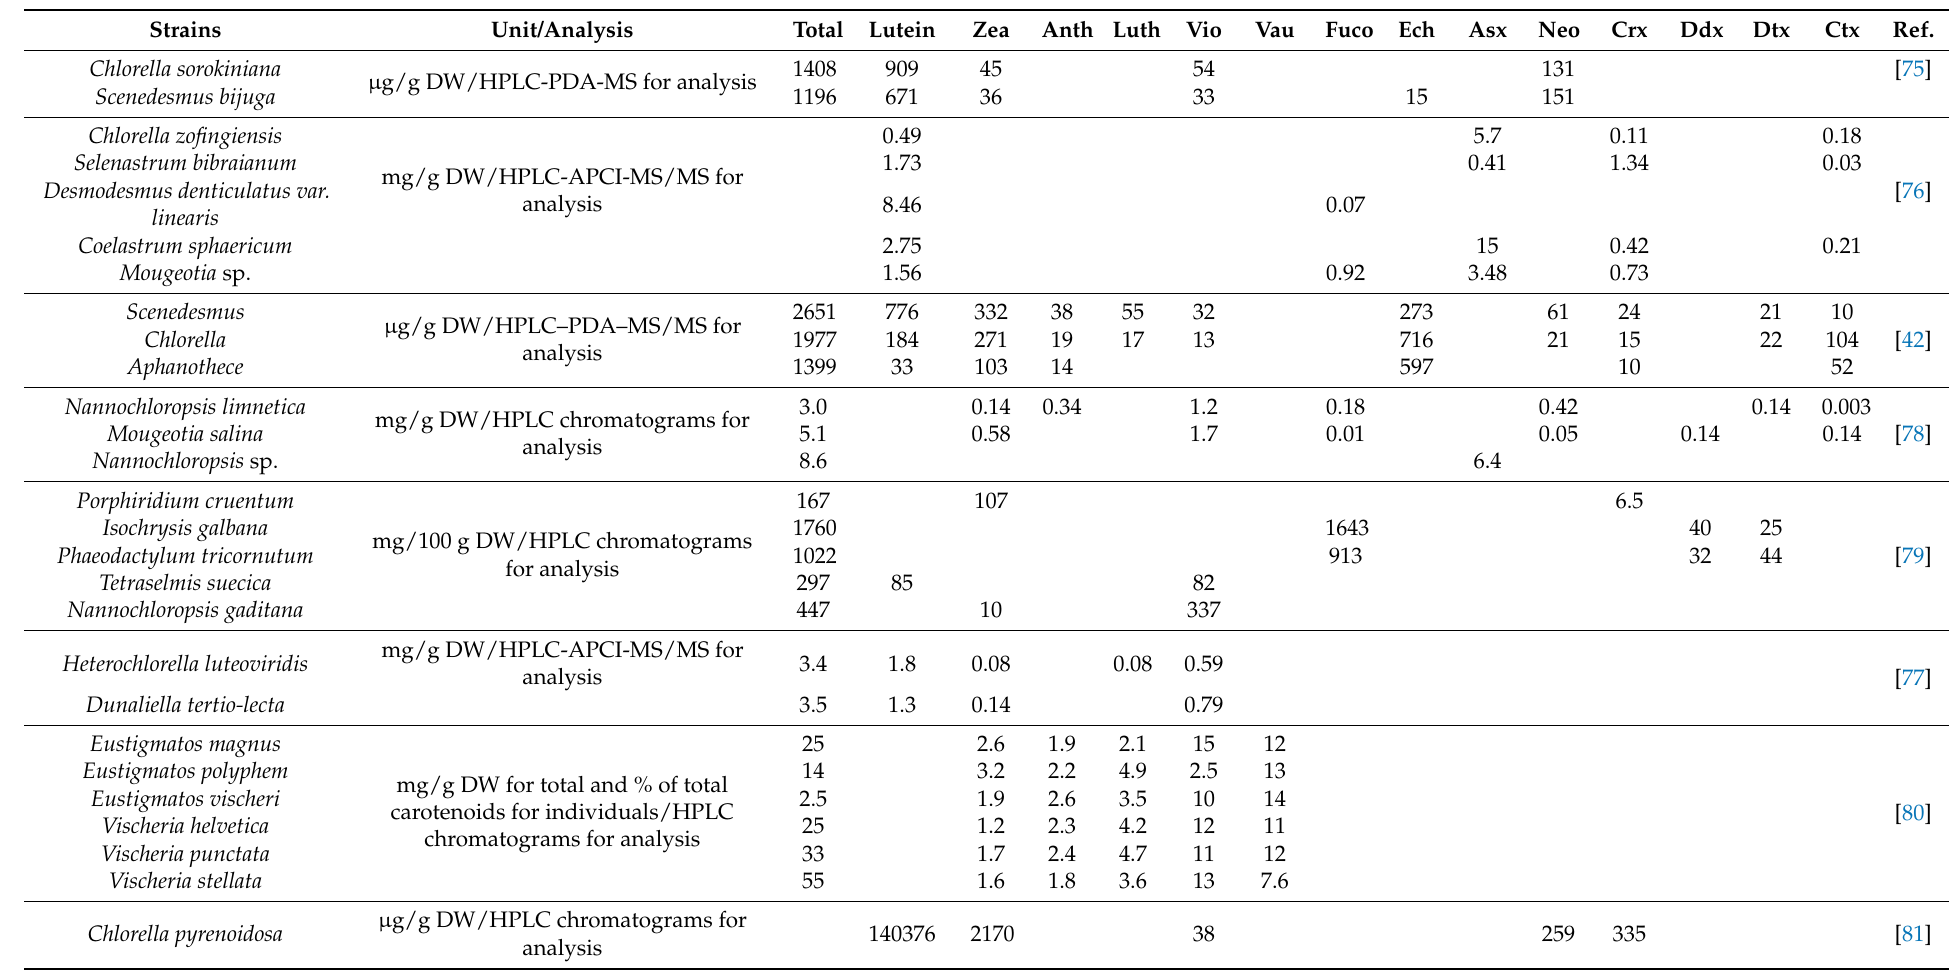
Table 2. Contents of carotenoids other than α - and β -carotene in different microalgae